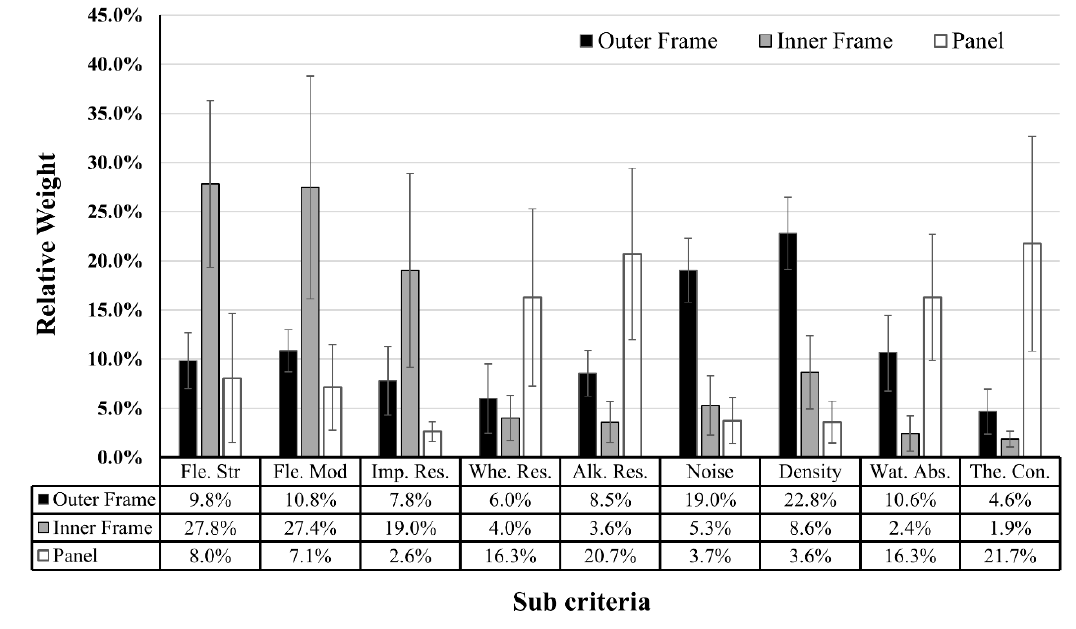
Figure 5. Overall relative weights of concrete form materials Table 6. Allowable formwork material properties according to the performance criteria.